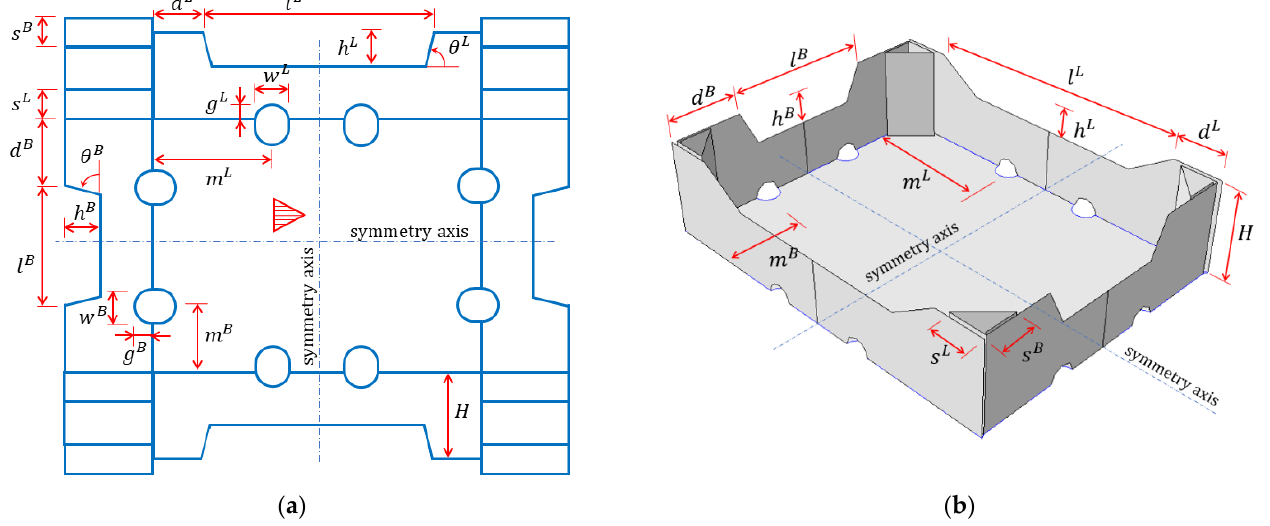
Figure 2. Parametric model used in the study: ( a ) 2D grid and ( b ) 3D scheme (for clarity, w L , g L , w B , g B , θ L , and θ B parameters are not shown